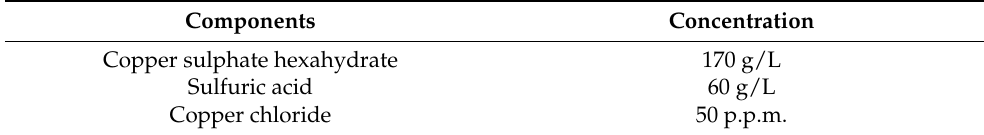
Table 3. Galvanic bath for pure copper deposition.